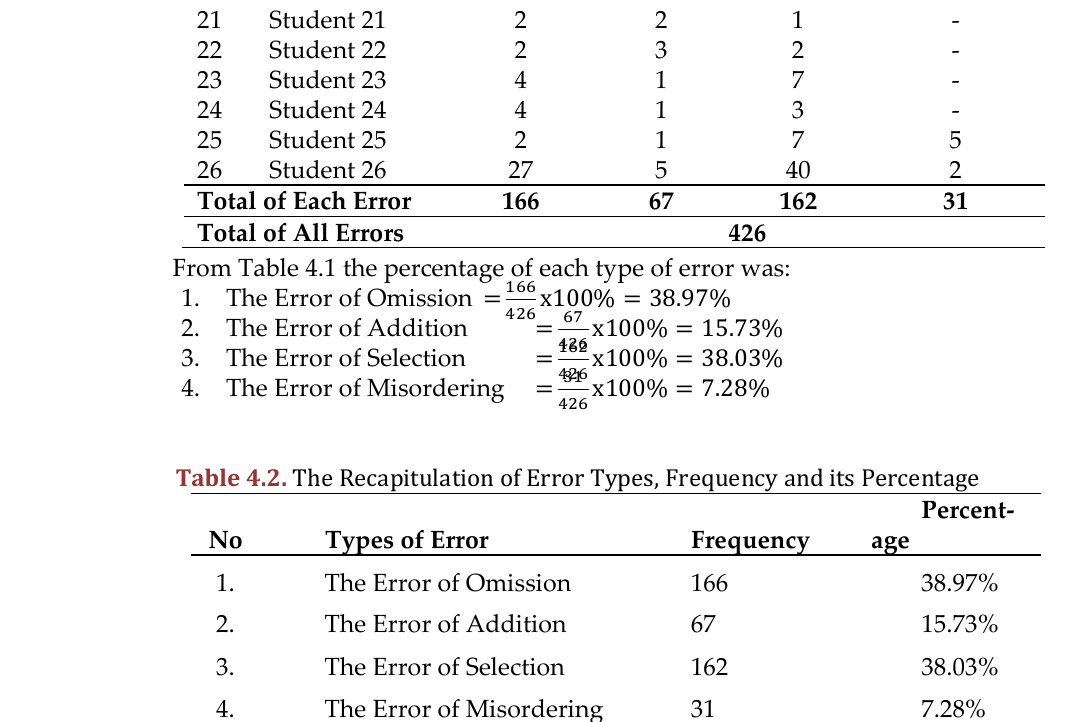
From Table 4.1 the percentage of each type of error was: